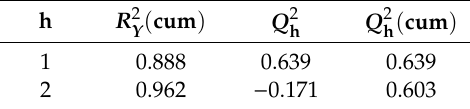
Table 2. Principal component validation of M.